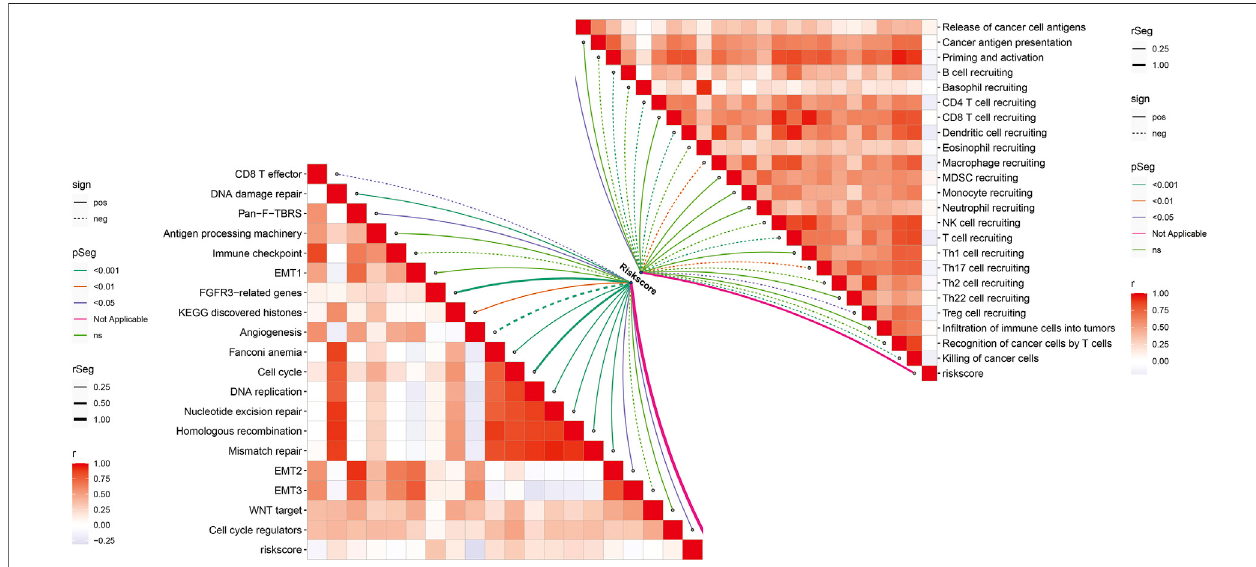
FIGURE 8 | Necroptosis-relevant risk model links with the cancer – immunity cycle and known biological processes in pancreatic cancer. Spearman ’ s correlation analysis was conducted between the necroptosis-relevant risk score and all steps within the cancer – immunity cycle and known biological